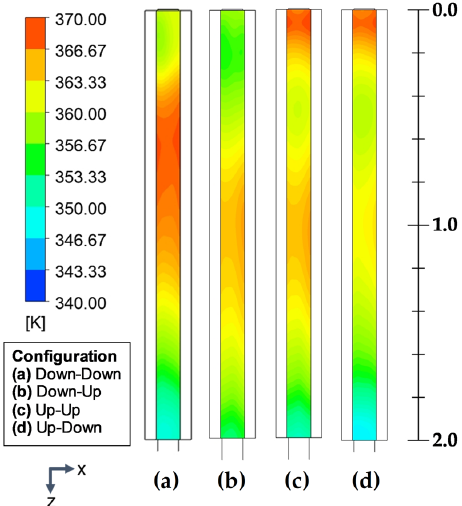
Figure 8. Temperature contours in the flat plate receiver, first pass (Flow 1: 0.01 kg/s).